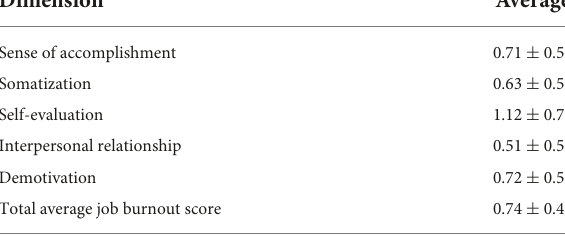
TABLE 2 Job burnout scores of military soldiers and officers ( n = 1062, ¯ x ± s).